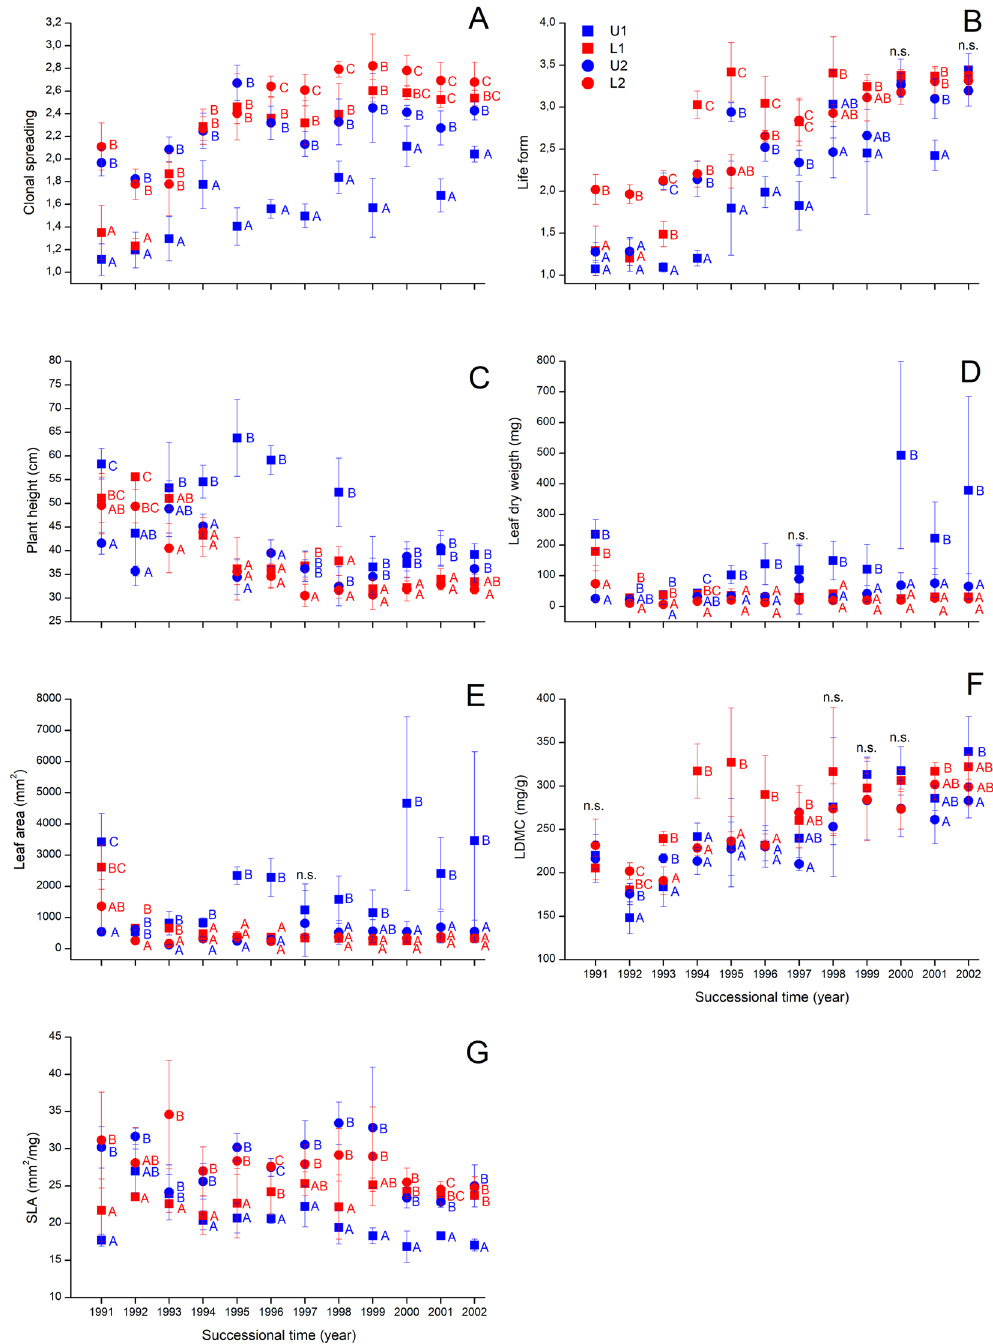
Figure 2. Temporal change of community-weighted means (CWMs) of vegetative traits. Notations: rectangle – sites at the eastern part of the reserve; circle – sites in the western part of the reserve; blue – sites laying near to the dune top; red – sites laying near to the dune slack. Significant differences were indicated by superscript letters (Univariate GLM and Tukey test). Clonal spreading ability was based on the four ordinal categories of the CLO-PLA database 29 ; while life form was based on qualitative data for plant life form transformed to an ordinal scale based on the potential life span of each